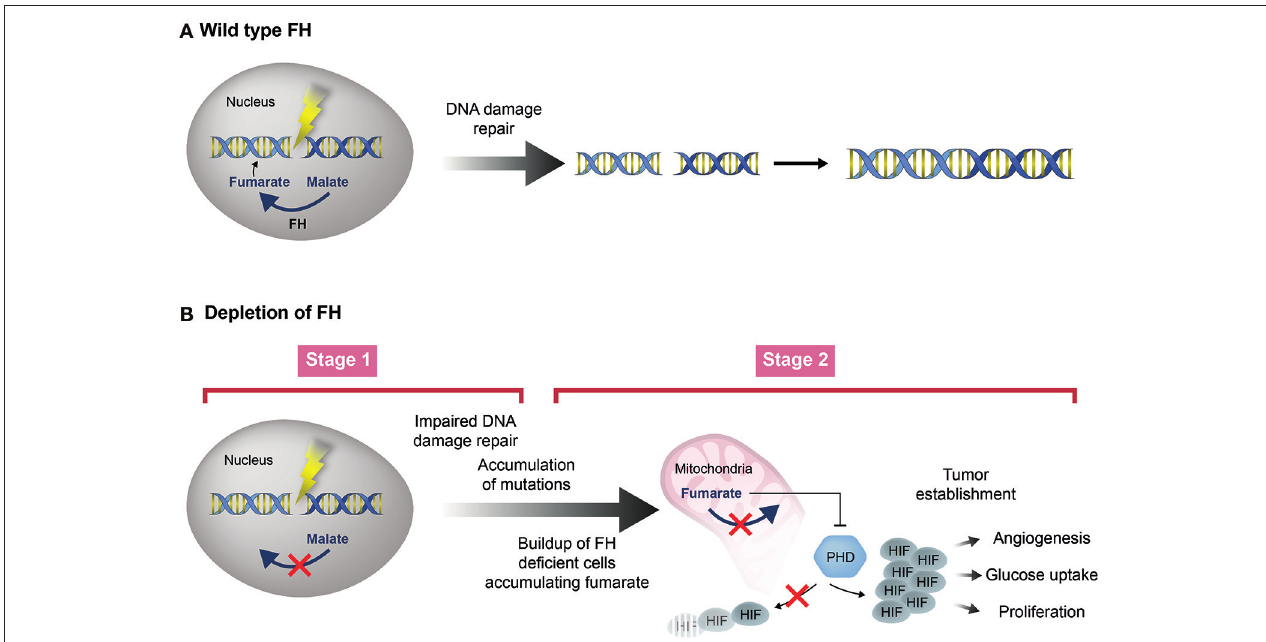
FIGURE 4 | Two stage model of fumarase depletion leading to tumorigenesis. (A) Fumarase and its metabolite fumarate are involved in the DNA damage response in human cells. (B) Depletion of fumarase can contribute to the tumorigenesis process. In the first stage (Stage 1), biallelic inactivation of fumarase in a single tumor cell may abolish the ability of the cell to generate fumarate in the proximity of the cellular DNA, thereby decreasing genomic stability, leading to creation of additional mutations. At this stage, the fumarate concentration in the single tumor cell may not be sufficient for HIF stabilization. In the second stage (Stage 2), proliferation of the fumarase deficient cells may form a closely positioned cell population, in which the fumarate levels rise and the concentration required for HIF stabilization can be